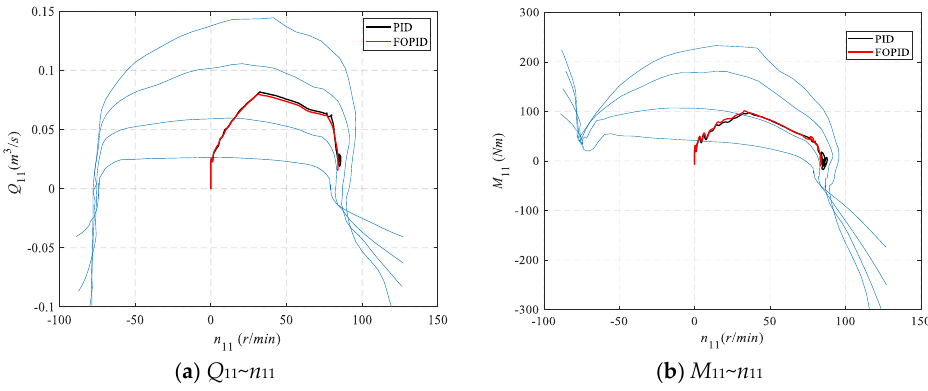
Figure 17. Start-up process curves in the full-characteristic curve of the 1# PSU.